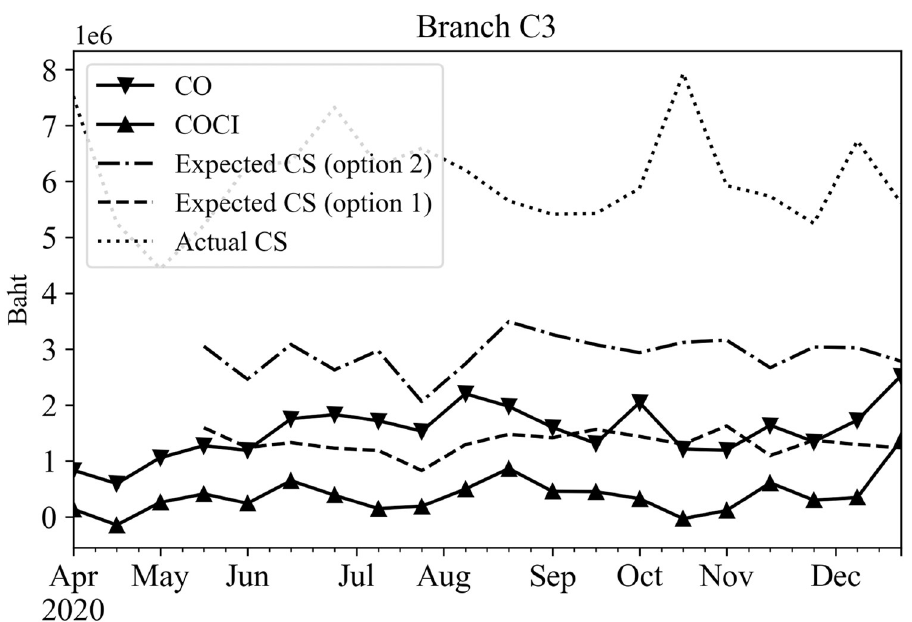
Fig 12. Expected and actual cash stocks, CO, and COCI of an example branch that opens Monday—Friday. https://doi.org/10.1371/journal.pone.0268753.g012 triangles) the actual COCI (solid line with upward triangles) data. Since the actual CO and COCI values reflect cash withdrawal and deposit behavior of the customers, they should be treated as guidelines to set the cash stock level. These values were used to compare the expected cash stock via options 1 and 2. Figs 10–12 show examples of the actual CO or COCI, actual